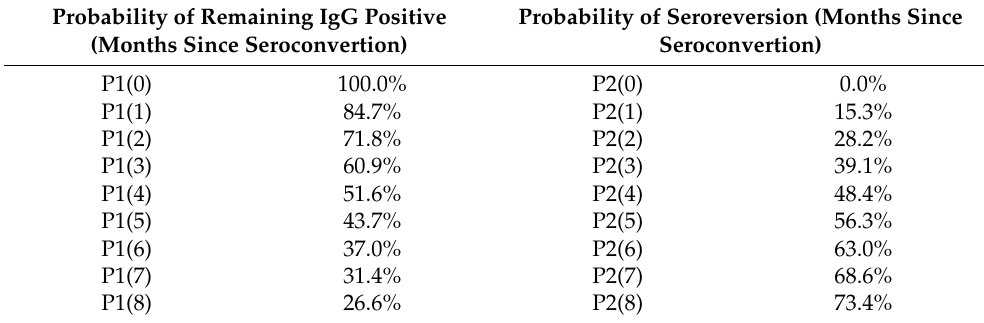
Table A1. Assumed probabilities of remaining IgG positive (P1) and seroreverting (P2) n months after